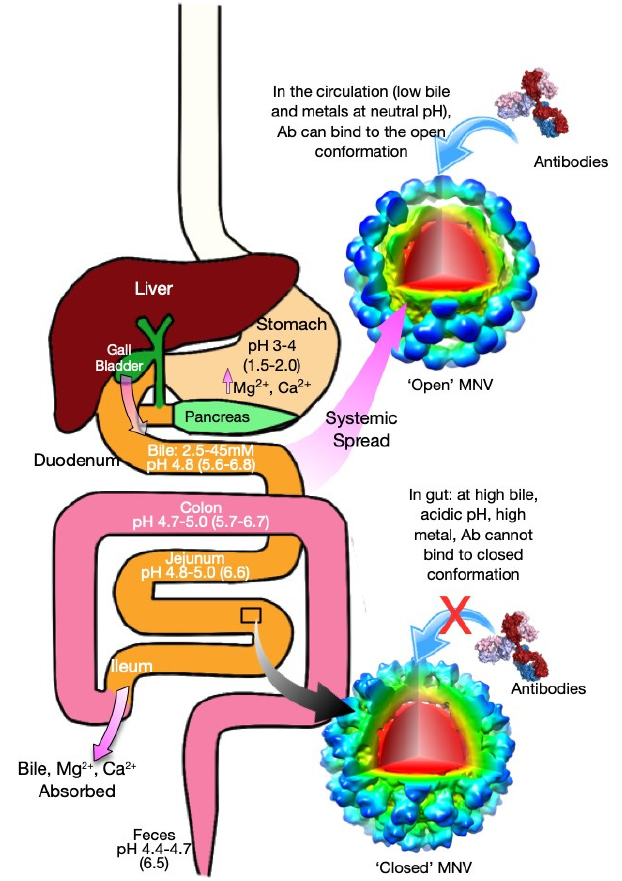
Figure 7. Schematic of the various states of MNV as it travels through the alimentary canal. Where available, the numbers cited are for the murine where the parenthetical values are for humans for comparison. There are three signals that cause the contraction of the P domain onto the shell and the transition of the P domain loops to the closed conformation: low pH, binding of bile salts, and the binding of metals. These conditions are found throughout the alimentary canal. In the stomach, the low pH not only causes contraction but also solubilizes ingested metal salts. In the duodenum, the pH increases to 4.8 [44], but large amounts of bile salts are deposited via the gall bladder. Here the concentration comes from measurements on humans but the flux of bile in mice is significantly greater [47]. Throughout the small intestine, the pH remains acidic, and the metal and bile concentrations remain high. In the ileum, most of the bile salts and metals are absorbed. Finally, in the colon, there are still significant metal concentrations in the ascending colon and the pH remains significantly acidic. Interestingly, the pH of the feces is also rather acidic. Therefore, the conditions throughout the alimentary canal favor the contracted, closed conformation of MNV that blocks antibody binding while enhancing receptor binding. This reverses once the infection spreads outside the intestine where the neutral pH, low metal, and low bile concentrations favor the extended conformation with the open conformation in the P domain that favors antibody over receptor binding. Not drawn to scale.